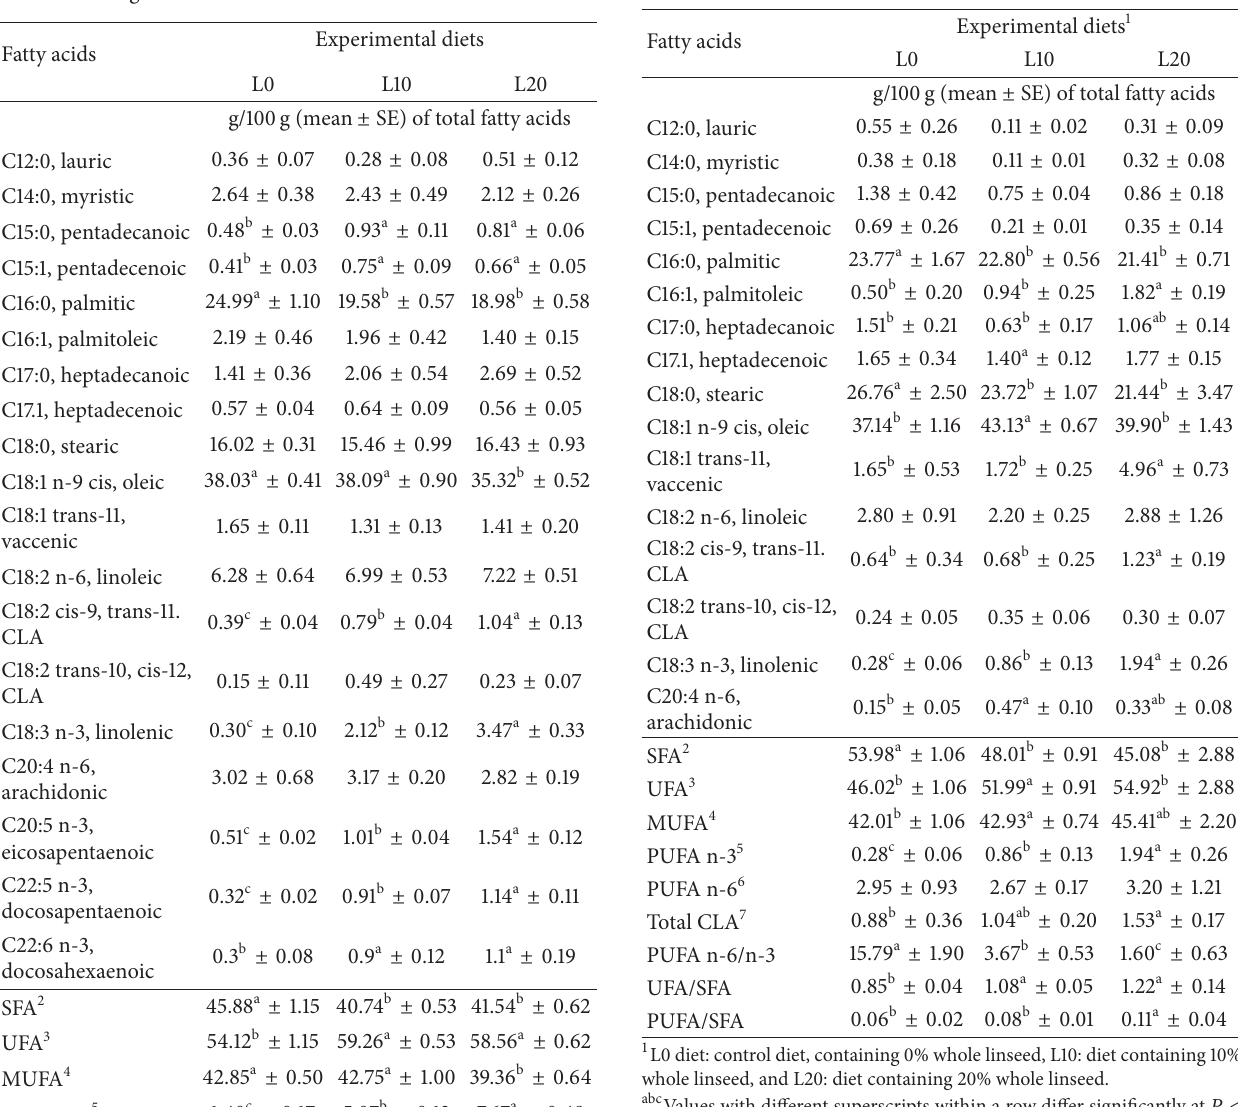
Table 6: Fatty acid profiles of the subcutaneous fat of goats fed diets containing different levels of whole linseed.